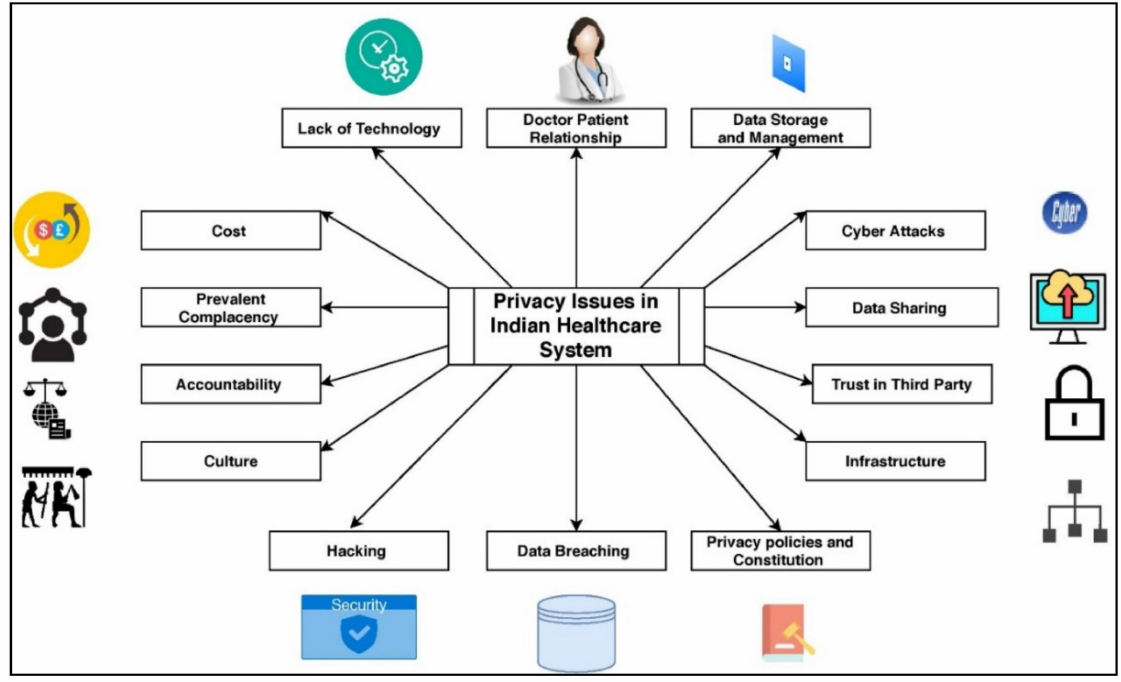
Figure 9. Privacy issues in the Indian Healthcare